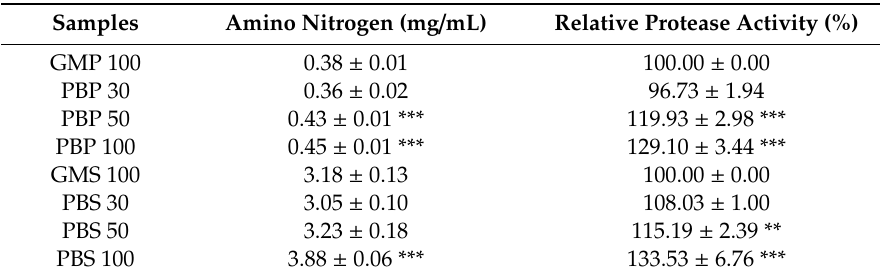
Table 1. Amino nitrogen level and relative protease activity of each paste and sauce to evaluate PBL koji paste and sauce fermentation. The amino nitrogen level of each paste and sauce was analyzed. In addition, the protease activity of each paste and sauce was